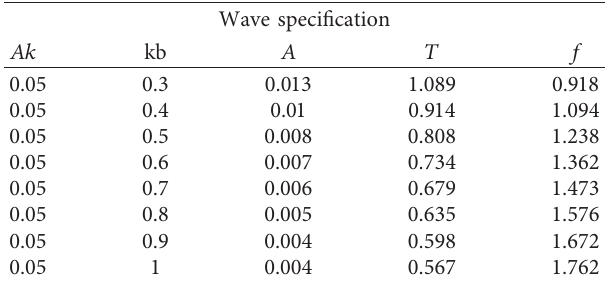
Table 8: Wave characteristics.